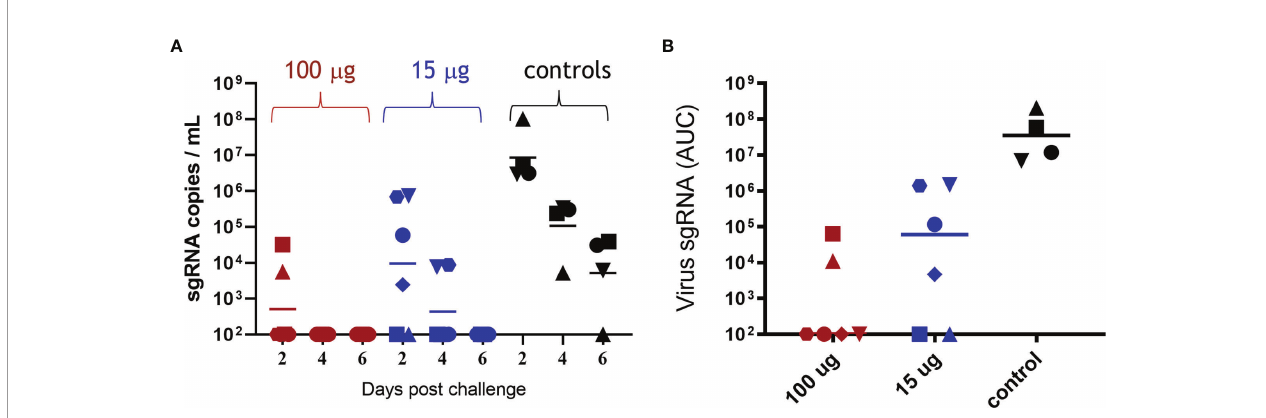
FIGURE 3 | Viral load in bronchoalveolar lavage following SARS-CoV-2 challenge. Rhesus macaques were vaccinated and challenged as described in Figure 2 . sgRNA was measured in bronchoalveolar lavage on days 2, 4, and 6 post-challenge. (A) sgRNA copies per ml BAL are shown for each animal in the 100- m g ABNCoV2 group by red symbols, in the 15- m g ABNCoV2 group by blue symbols, and in the non-vaccinated control group by black symbols. The symbol shapes identify individual animals; the same symbols are used for the same animals throughout all post-challenge data. Horizontal bars depict geometric mean values. (B) Total amount of sgRNA in BAL per animal (symbols) and median values (horizontal bars) are calculated as area under the curve (AUC). Signi fi cant differences by Mann – Whitney test were seen between each vaccinated group compared with the control group ( p =